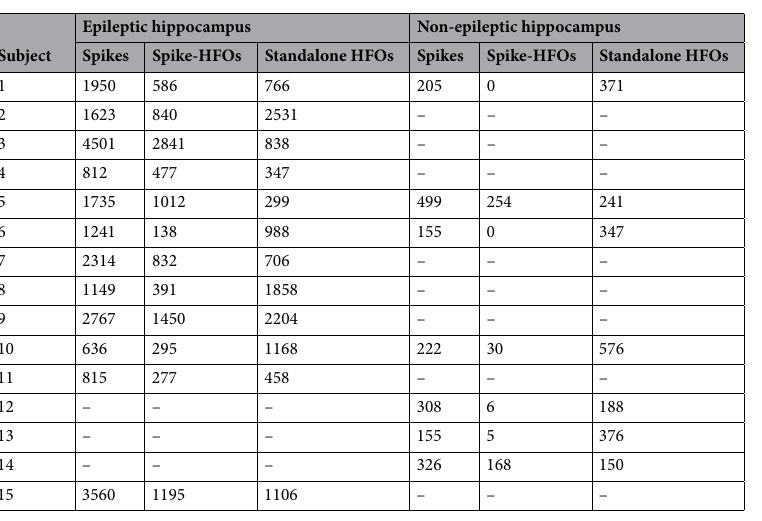
Table 2. Rates of spikes, spike-HFOs and standalone HFOs per 10 min for individuals within resting-state